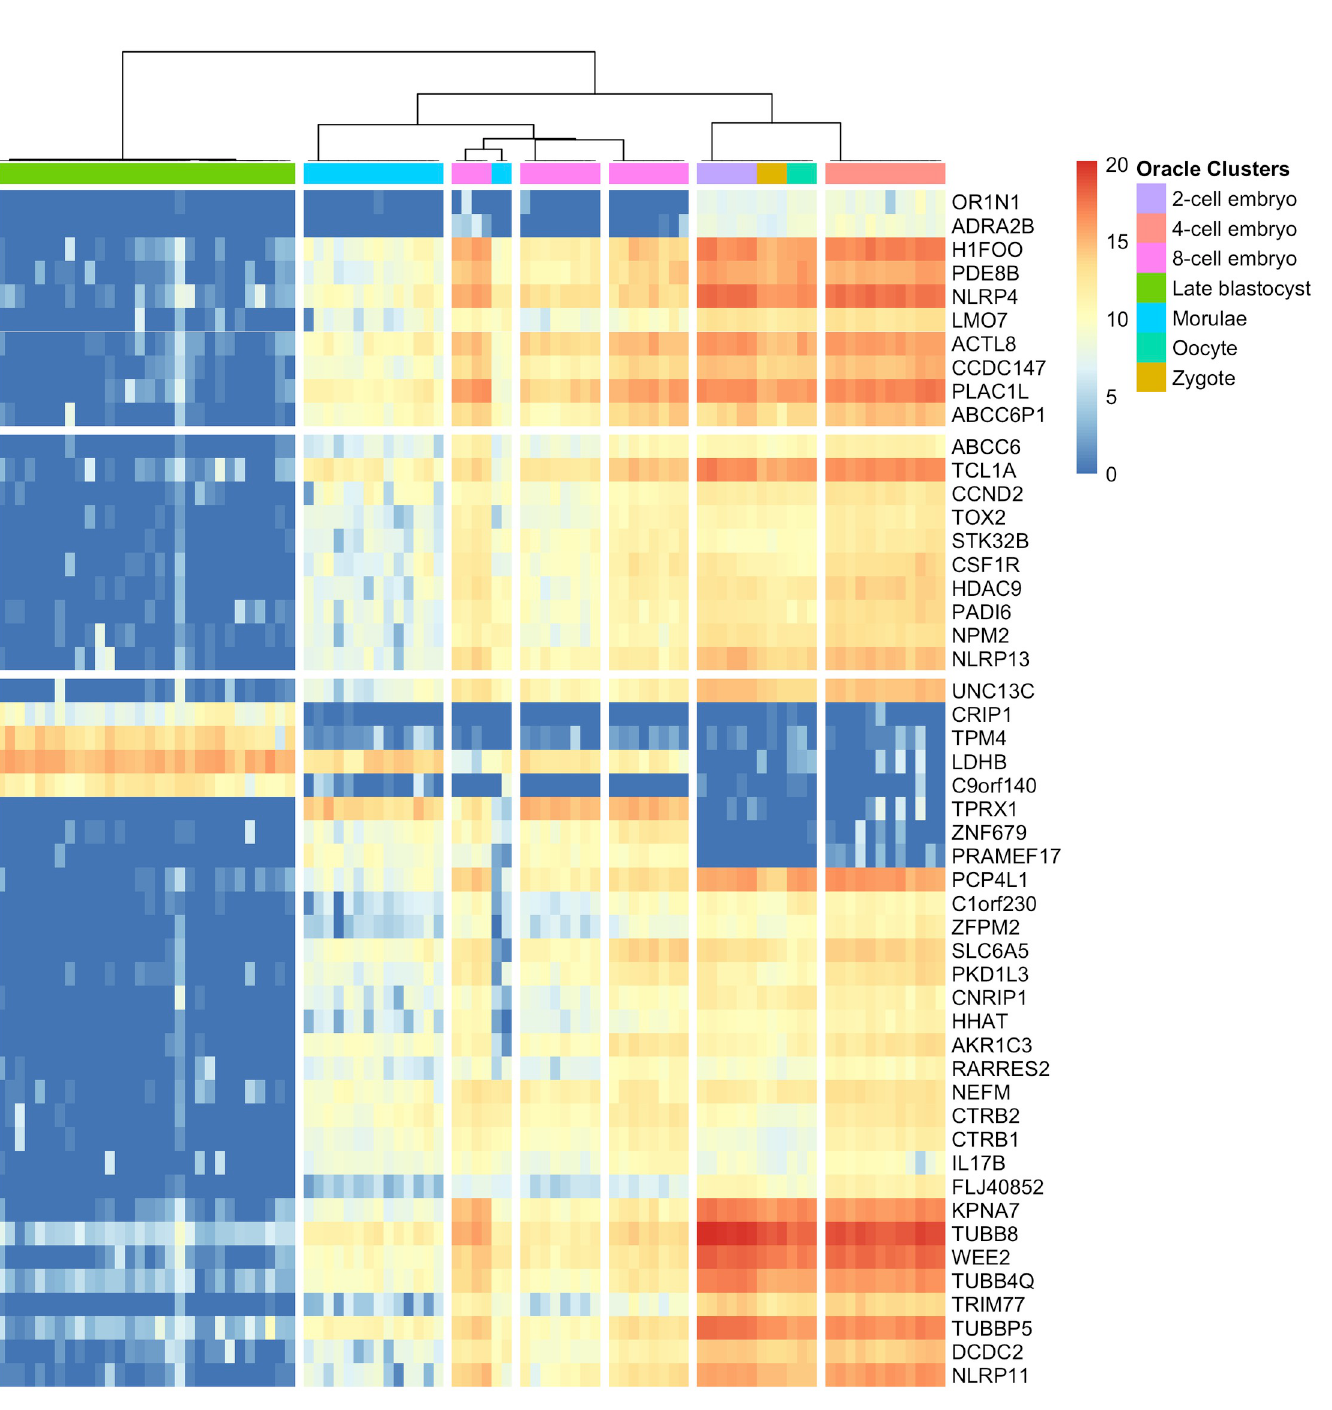
Fig 3. Gene expression matrix of the top 50 differentially expressed genes identified by IMPACC in Yan data set, with subgroups defined by the final consensus matrix of IMPACC.